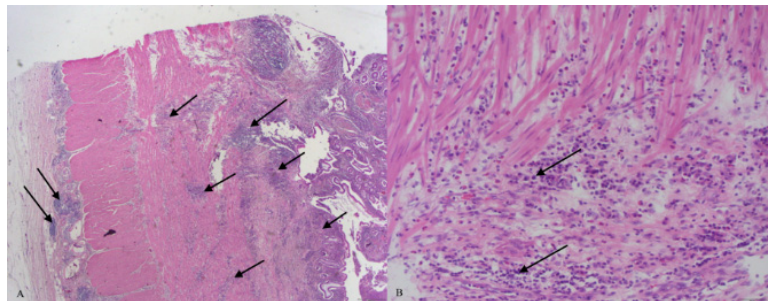
Figure 2. Histopathologic analysis of surgical specimen of colon. Arrows show leukocyte infiltra- tion ( A ) HE 20 × , transmural inflammation on surgical specimen; ( B ) HE 200 × , inflammation cell infiltration of the muscular